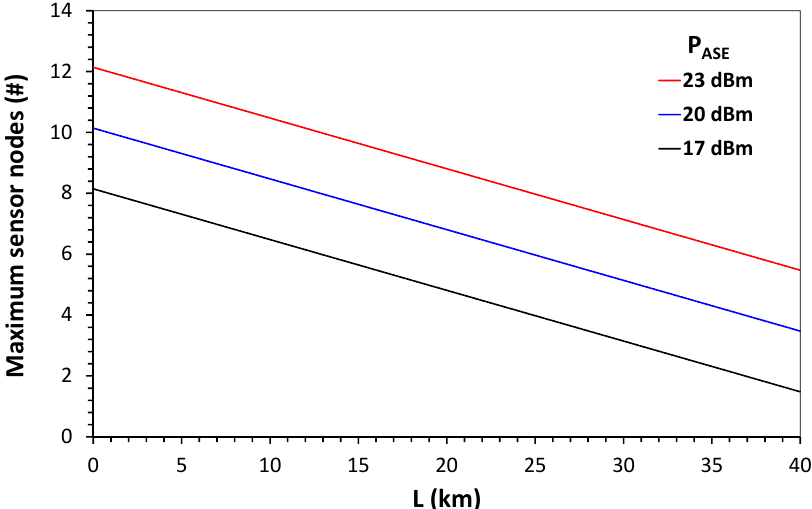
Figure 12. Plot of the number of nodes versus the link length (L) using (1) and the data cited above for three levels of ASE source optical power P ASE .